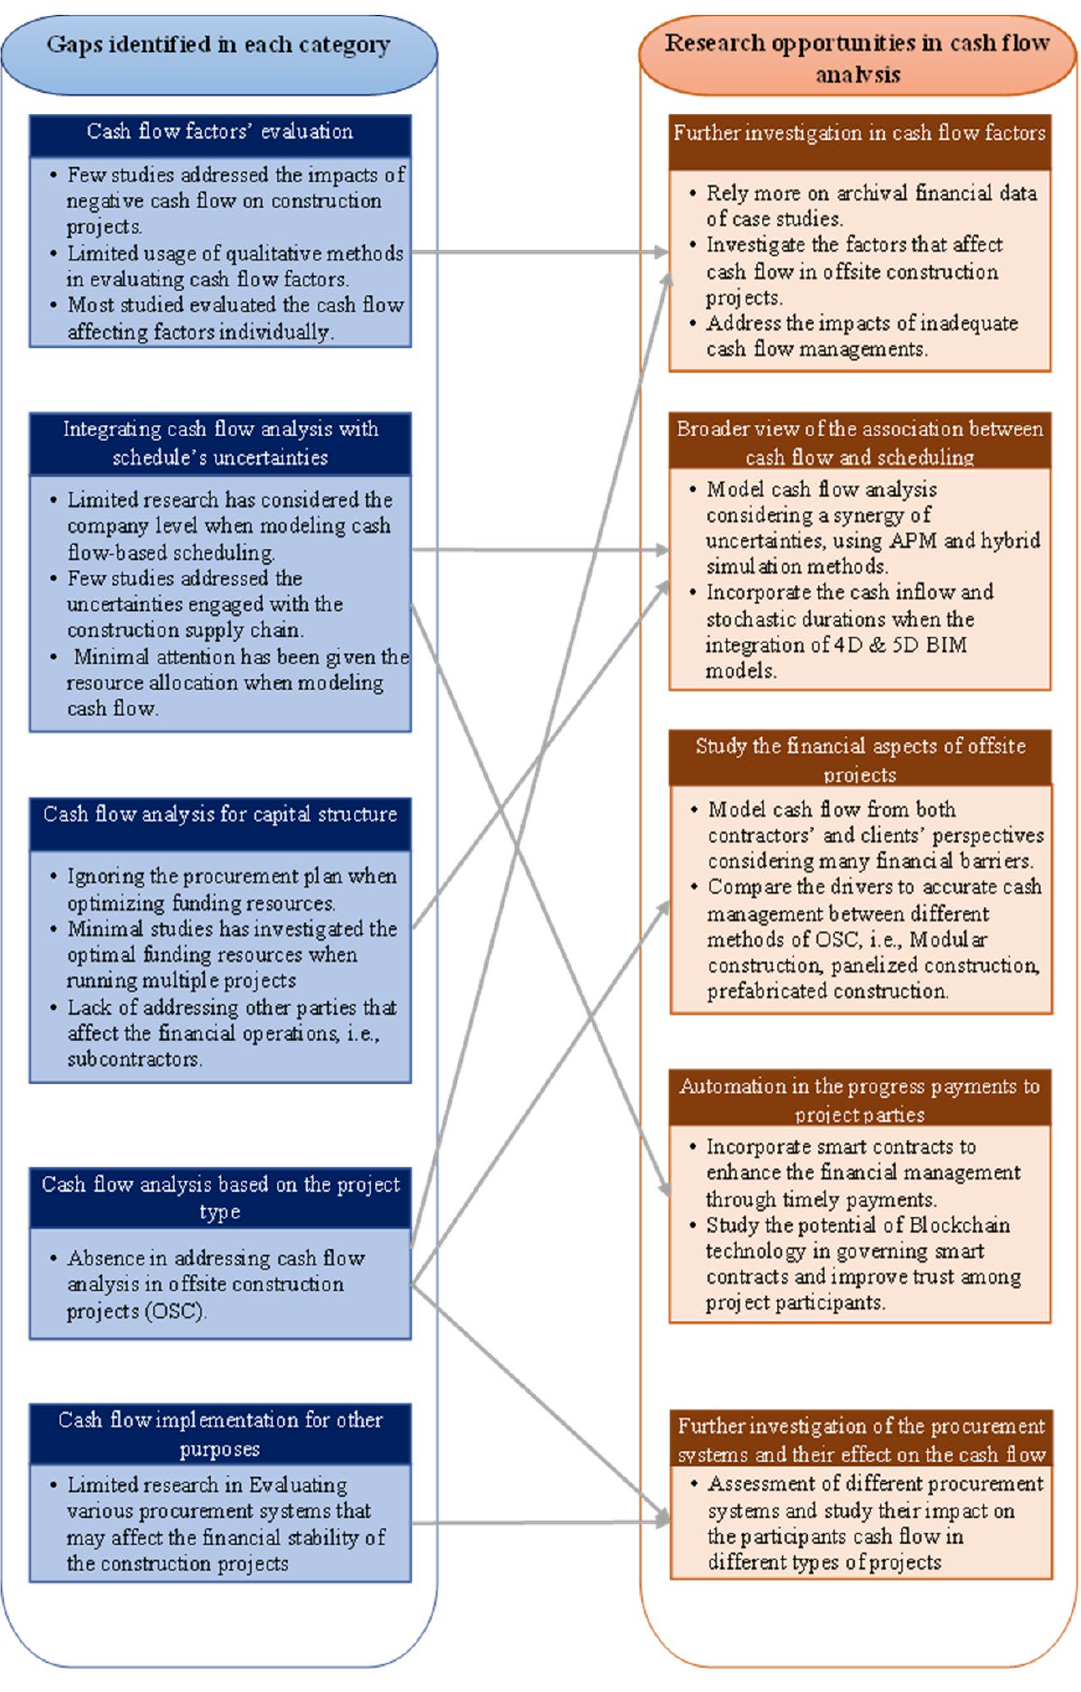
Figure 11. Summary of identified gaps and future direction in the cash flow domain.